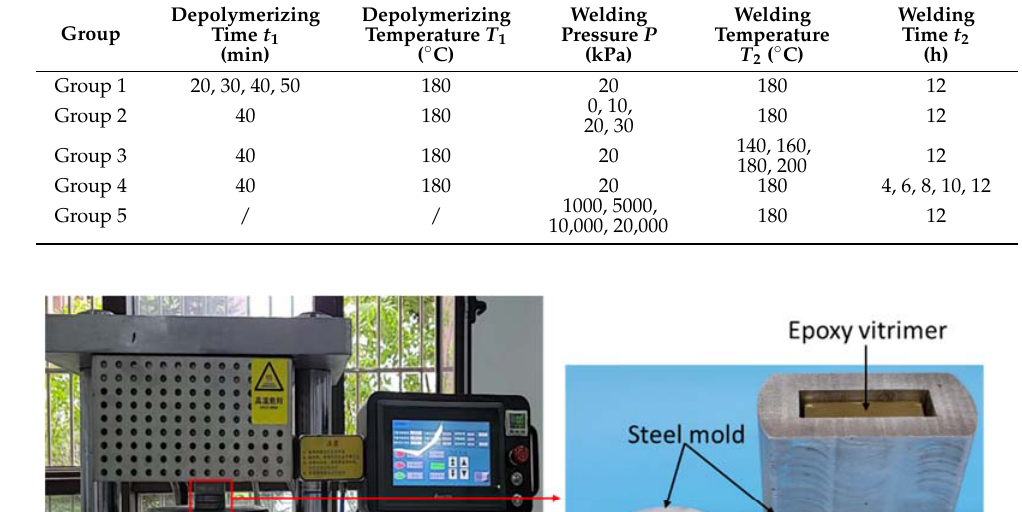
Figure 3. Experimental setup for welding.